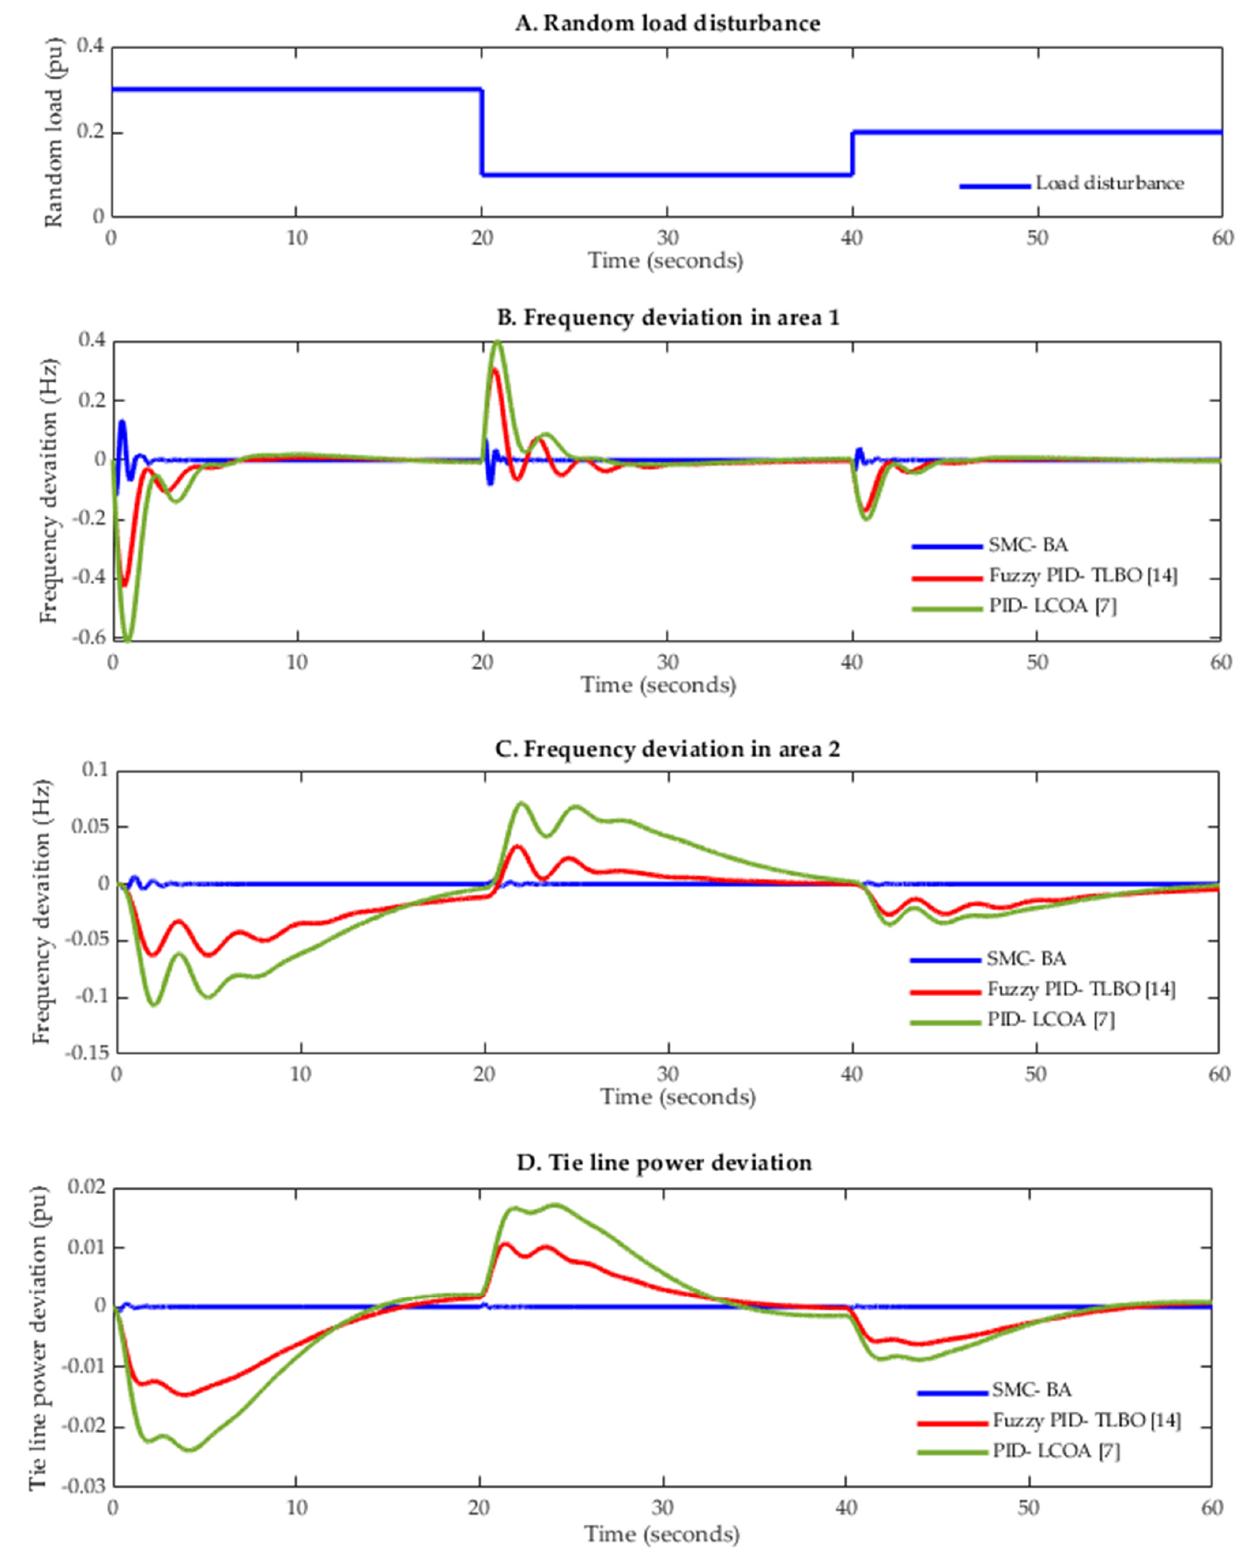
Figure 17. Dynamic response of the system with different controllers under parametric uncertainties, case 10 with a random load disturbance applied in area one. ( A ) Random load disturbance; ( B ) Frequency deviation in area 1; ( C ) Frequency deviation in area 2; ( D ) Tie line power deviation.